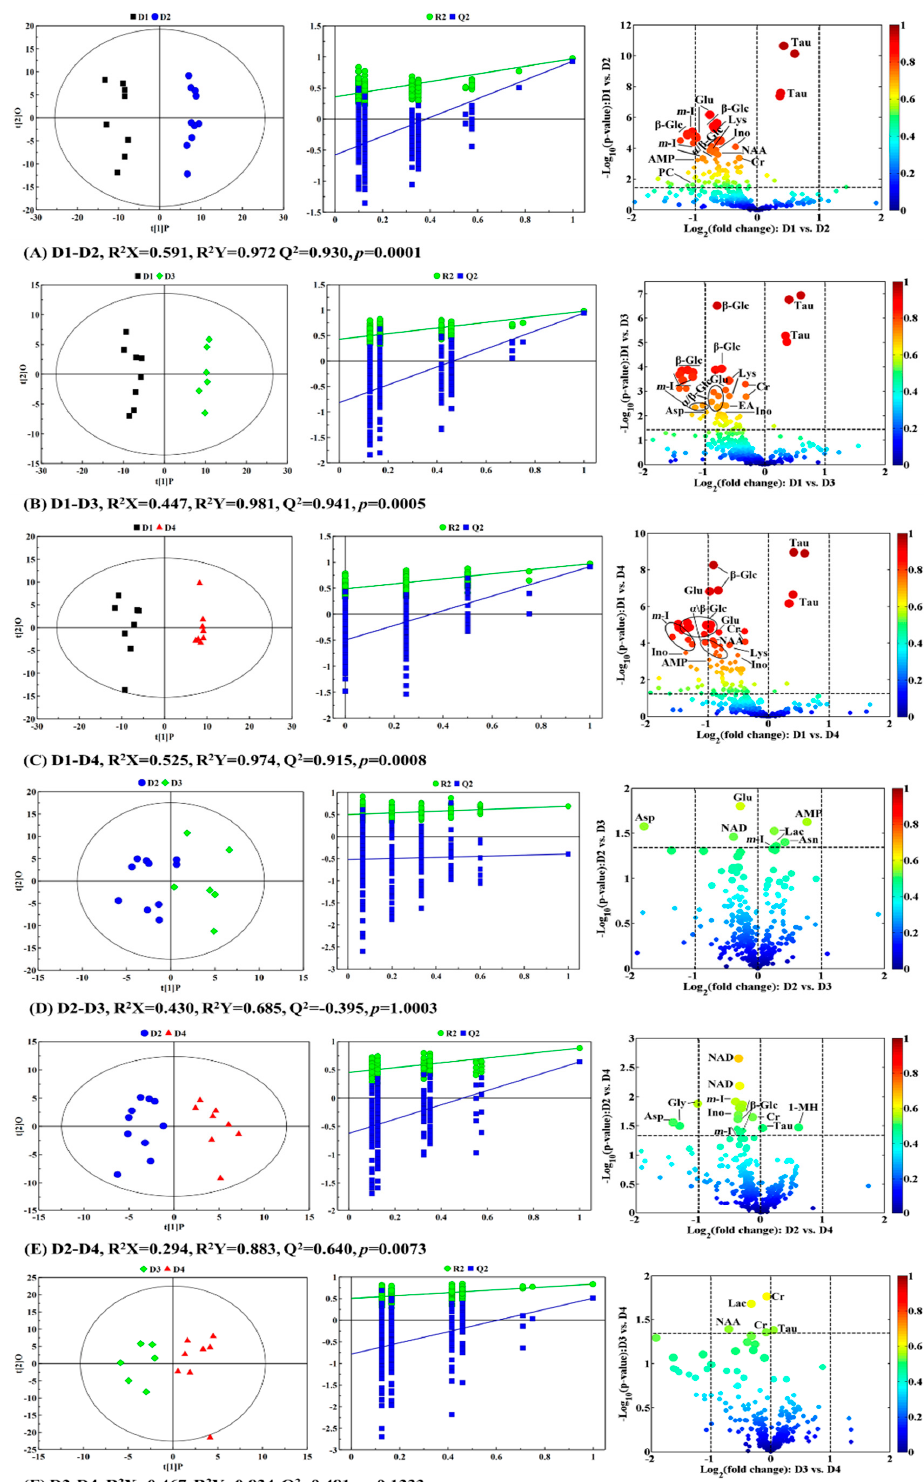
Figure 4. OPLS-DA scores plots (left panel), validation model plots (middle panel) by permutation tests ( n = 200), and corresponding volcano plots (right panel) derived from the 1 H-NMR spectra of the intestines of grouper fed diets containing di ff erent taurine contents at FD84. ( A ) D1-D2; ( B ) D1-D3; ( C ) D1-D4; ( D ) D2-D3; ( E ) D2-D4; ( F ) D3-D4. The big, middle and small points indicate the variable importance for the projection (VIP) value of the first 5%, second 5%, and the remaining 90%. Keys to the assignments are shown in Figure